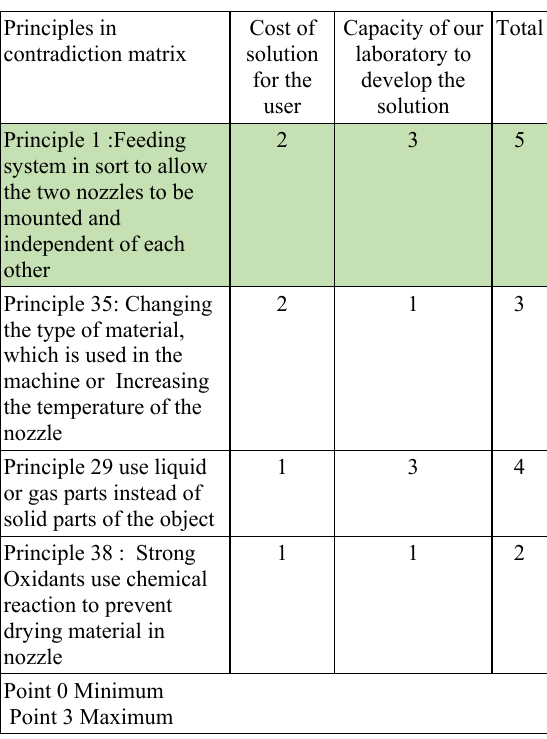
Table 4. Comparing of the proposed TRIZ solutions Principles in contradiction matrix